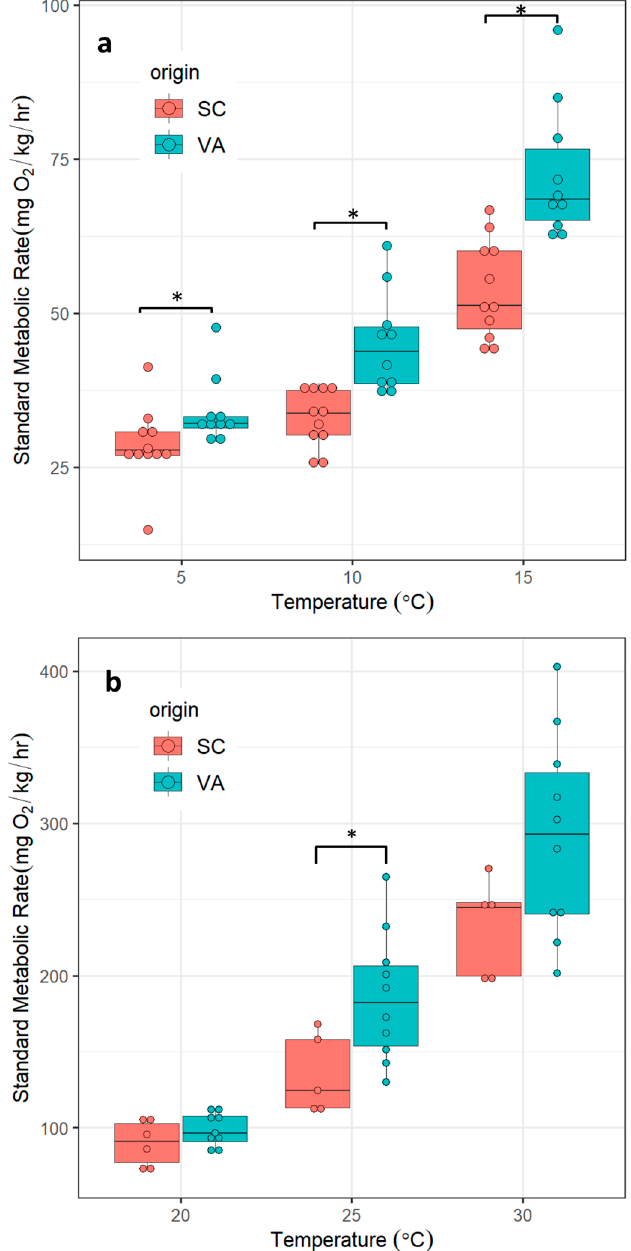
Figure 3. SMR of spotted seatrout from two genetically distinct populations measured at six discrete temperatures. SC = southern population, VA = northern population. ( a ) cold stress; ( b ) heat stress. Asterisks indicate significant di ff erences between groups ( p ≤ 0.05, two tailed Student’s t-test). In cold stress experiments, the origin of fish had a significant e ff ect on SMR ( χ 2 (1) = 8.97, p = 0.0027), as did temperature ( χ 2 (2) = 104.06, p < 0.0001). The fish–temperature interaction was also significant ( χ 2 (2) = 20.14, p < 0.001). Contrasts revealed that: (1) the e ff ect of temperature on SMR was significantly larger in individuals from the northern population versus individuals from ◦ ◦ ◦ ◦ the southern population (5 C to 10 C: b = − 6.65, t 38 = − 4.121, p < 0.001; 10 C to 15 C: b = − 6.59, t 38 = − 4.17, p <